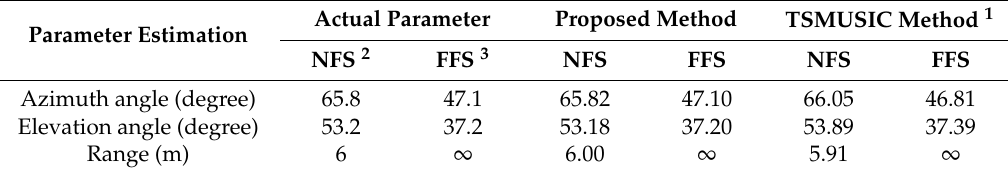
Table 1. Mixed source parameter estimation comparison (SNR = 20 dB).